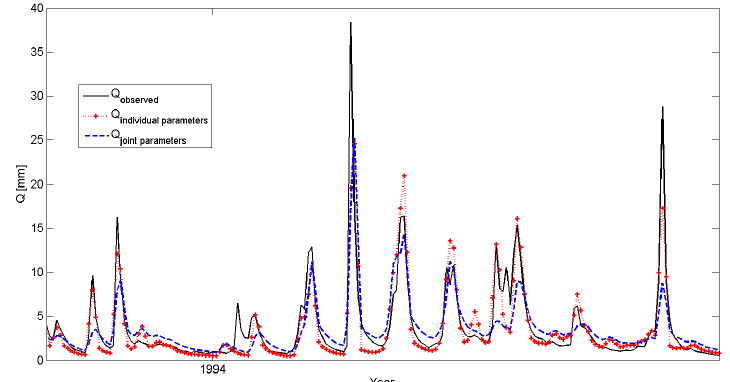
Figure 8. Runoff hydrographs for catchment 14 obtained using individual and leave-one-out common calibrations of HBV using the GK performance measure.